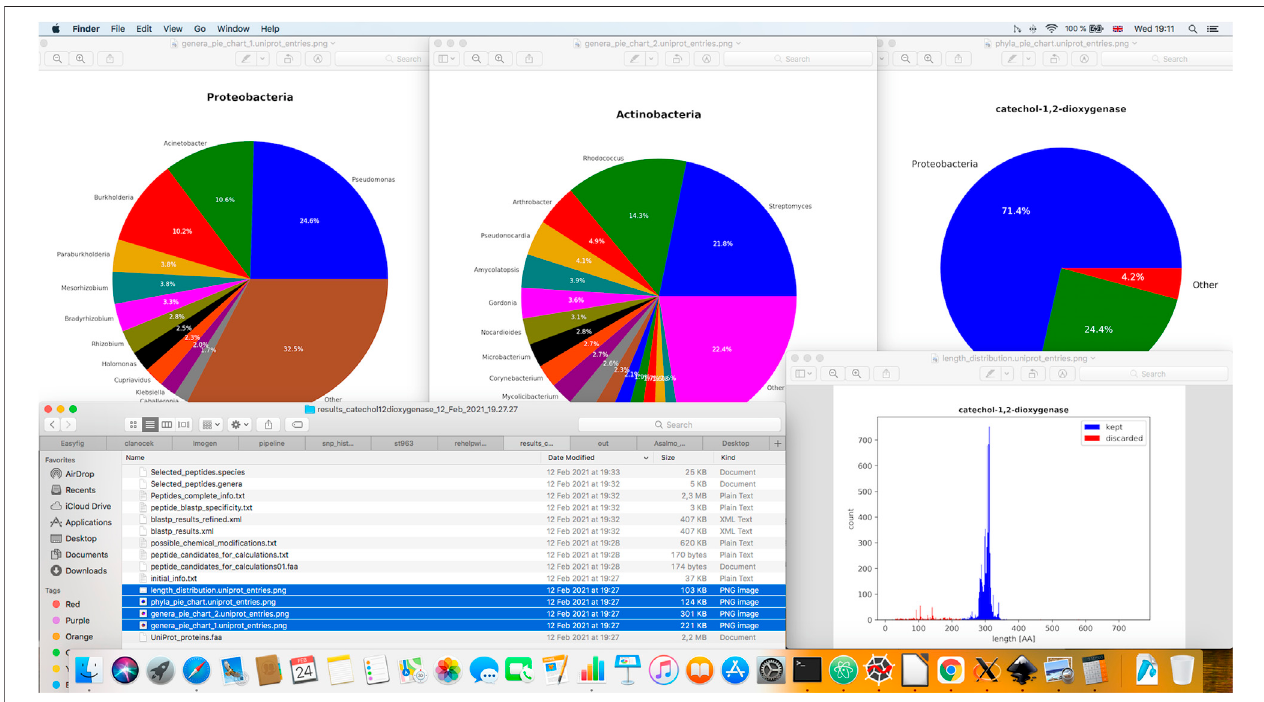
FIGURE3| IllustrationofvariousgraphicaloutputsgeneratedduringPepMANDISexecution.Theseincludethreepiechartsshowingtaxonomiccompositionofthe protein data retrieved from UniProt DB and a histogram displaying the size distribution of the retrieved proteins (in terms of the total number of amino acid residues).